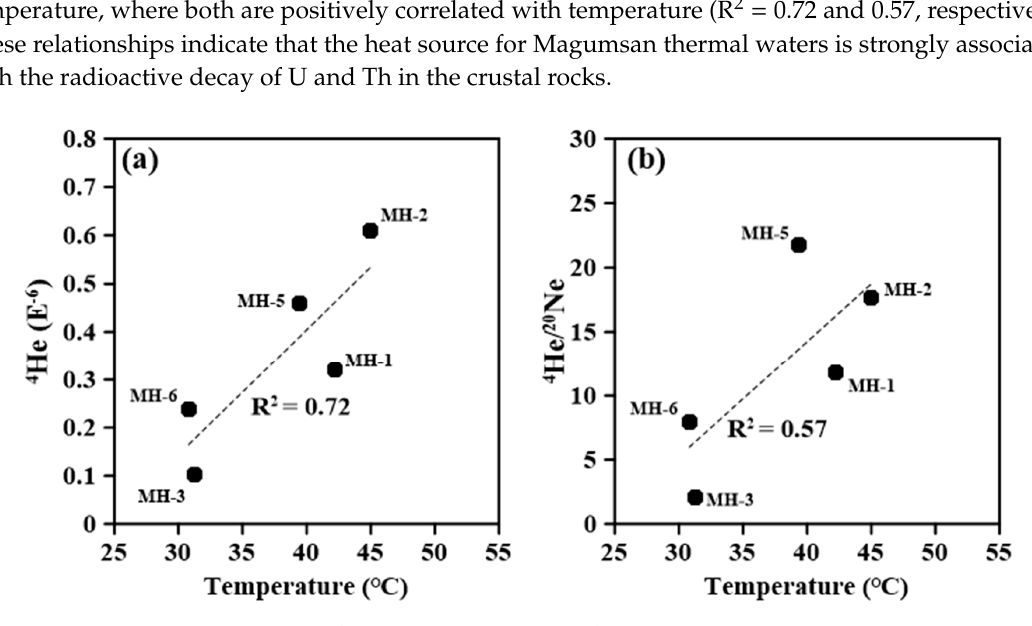
Figure 11. Correlations between 4 He concentration ( a ) and 4 He/ 20 Ne isotopic ratio ( b ) and temperature of thermal waters.